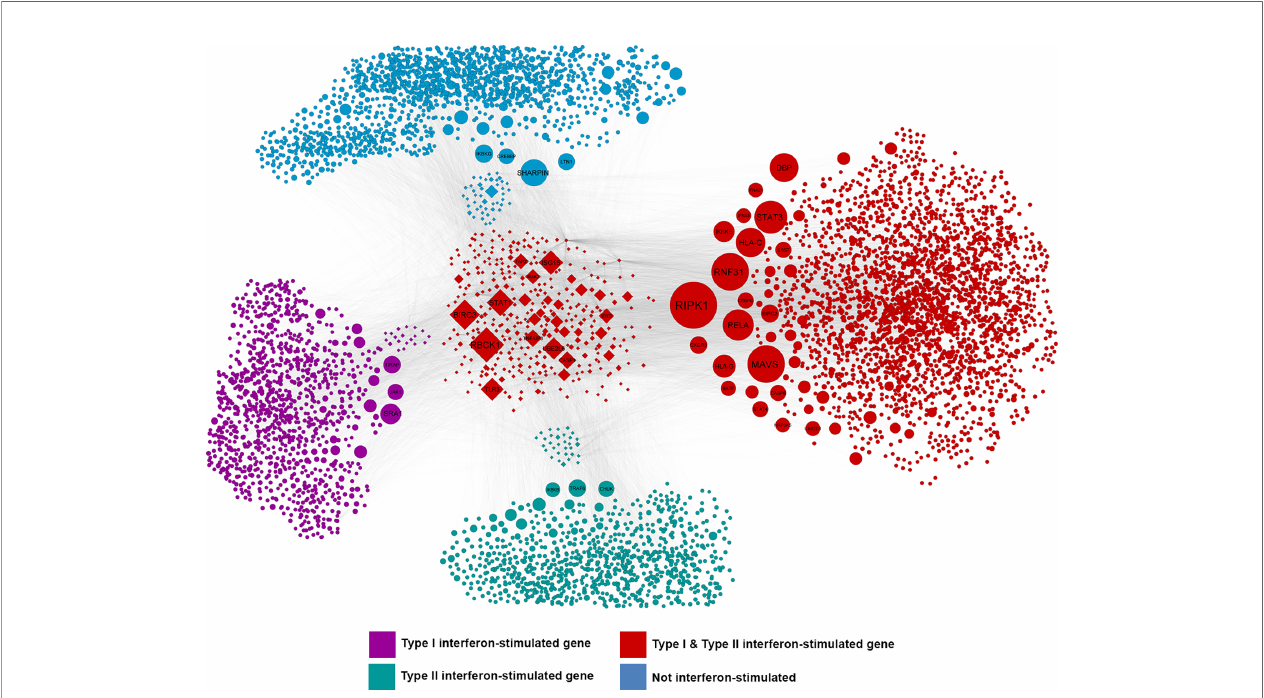
FIGURE 4 | Network of interactions between differentially expressed genes and the fi rst-order interactors of these genes or their encoded products in ZIKV-infected human iris pigment epithelial cell isolates from 20 individual donors. CHAT (37) identi fi ed nodes in the network that were connected to differentially expressed genes more than expected by chance. Node size is scaled to -log 10 of the false discovery rate where larger nodes are those that were identi fi ed as being more statistically signi fi cant. Purple nodes are type I interferon (IFN)-stimulated genes (ISGs); green nodes are type II IFN ISGs; red nodes are type I and II IFN ISGs; blue nodes are not IFN-responsive, as annotated by Interferome v2.0 (39). Diamond-shaped nodes represent differentially expressed genes (false discovery rate < 0.05 and fold- change > 2). Edges between nodes represent molecular interactions, as annotated by InnateDB (35). Type I and II IFN ISGs were statistically over-represented in this network. Hypergeometric test, p <